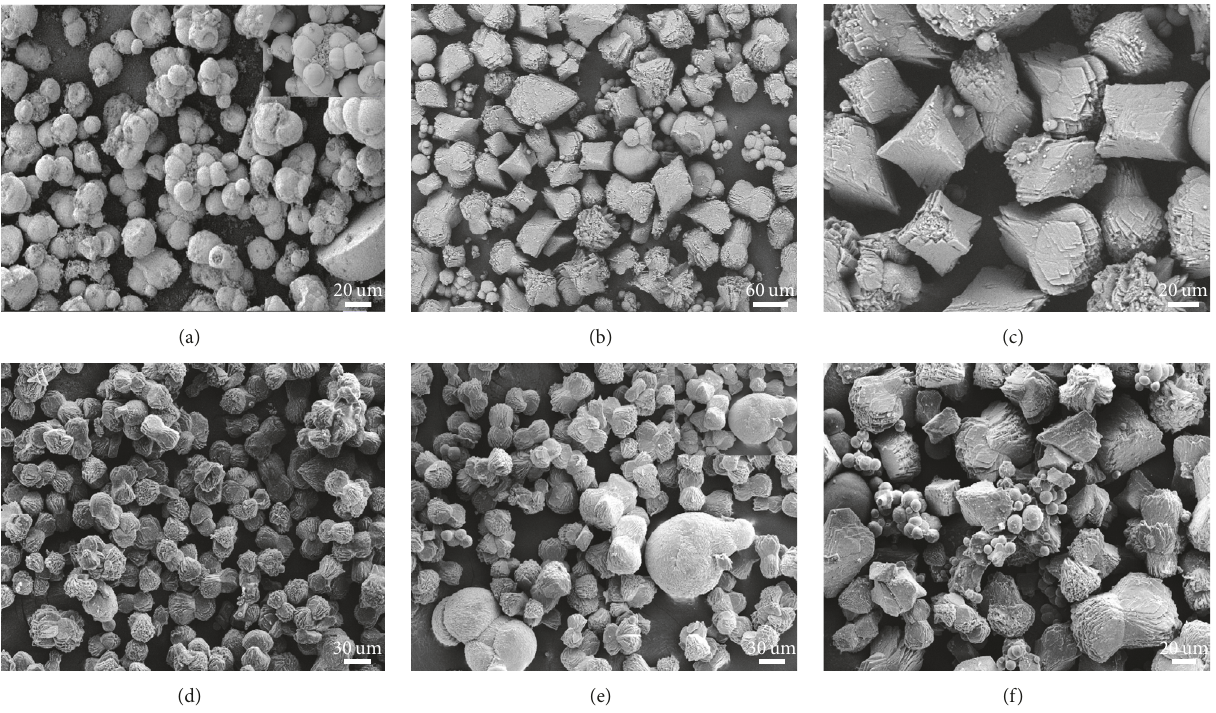
Figure 1: Typical SEM images of mineralized samples (a, b, c are mineralized samples at 0.1mol/L Ca 2+ and 12 h, 0.1 mol/L Ca 2+ and 24 h, and 0.1mol/L Ca 2+ and 48 h without MMT. d, e, f are mineralized samples under the same conditions with MMT).